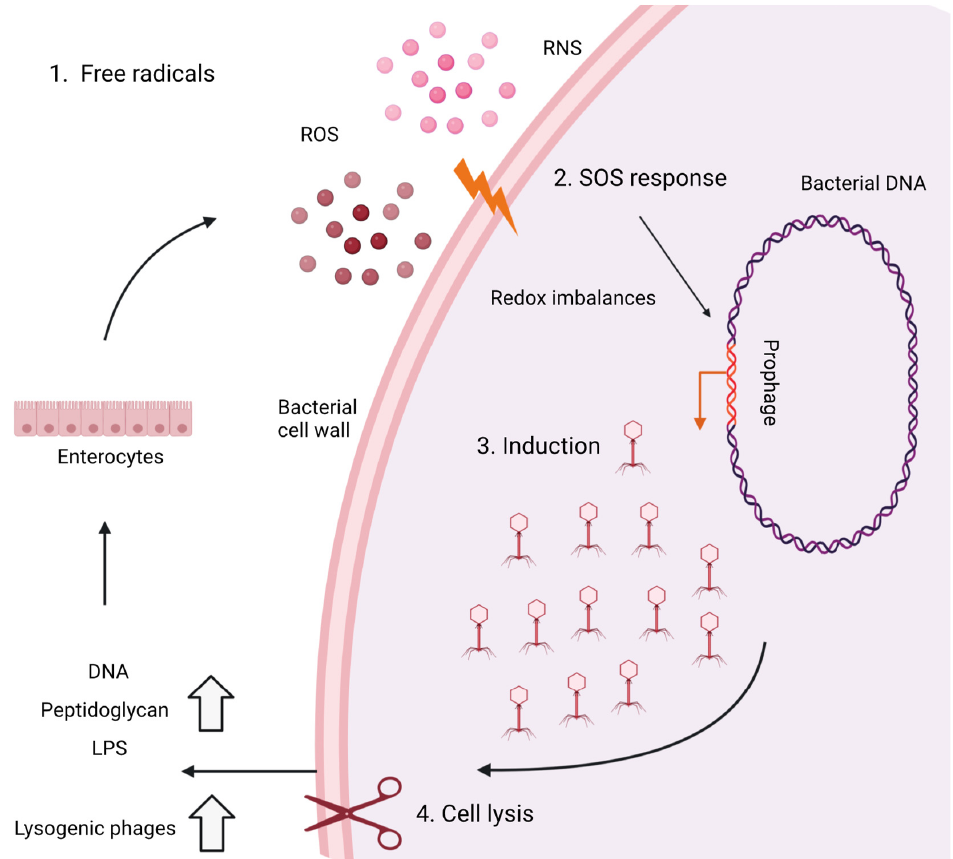
Figure 4. The hypothesis of phage-mediated lysis to sustain the positive inflammatory feedback loop in IBD patients. Intestinal inflammation stimulates the intestinal mucosa to produce stressors such as free radicals (e.g., ROS and NOS) (1) and triggers a stress response in the host bacteria called the “SOS response” (2). This response is a DNA damage response and leads to the induction of prophages (3), subsequent viral induction, and lysis of cells (4). Subsequently, pathogen-associated molecular patterns (e.g., LPS and peptidoglycan) are released, which in turn can stimulate the intestinal mucosa to produce further stressors, sustain the stress response in host bacteria, and thereby sustain the positive inflammatory feedback loop. Adapted from ref. [140] and created with BioRender.com.